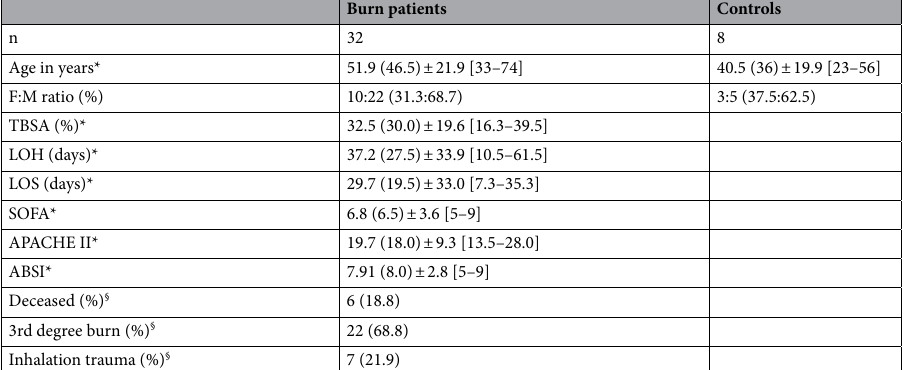
Table 1. Study group demographics. ABSI abbreviated burn severity index, APACHE II acute physiology and chronic health evaluation II, F:M female to male ratio, LOH length of hospitalization, LOS length of stay at intensive care unit, SOFA sequential organ failure assessment, TBSA total body surface area. *Indicated are mean (median) ± SD [interquartile range]. § Indicated are n